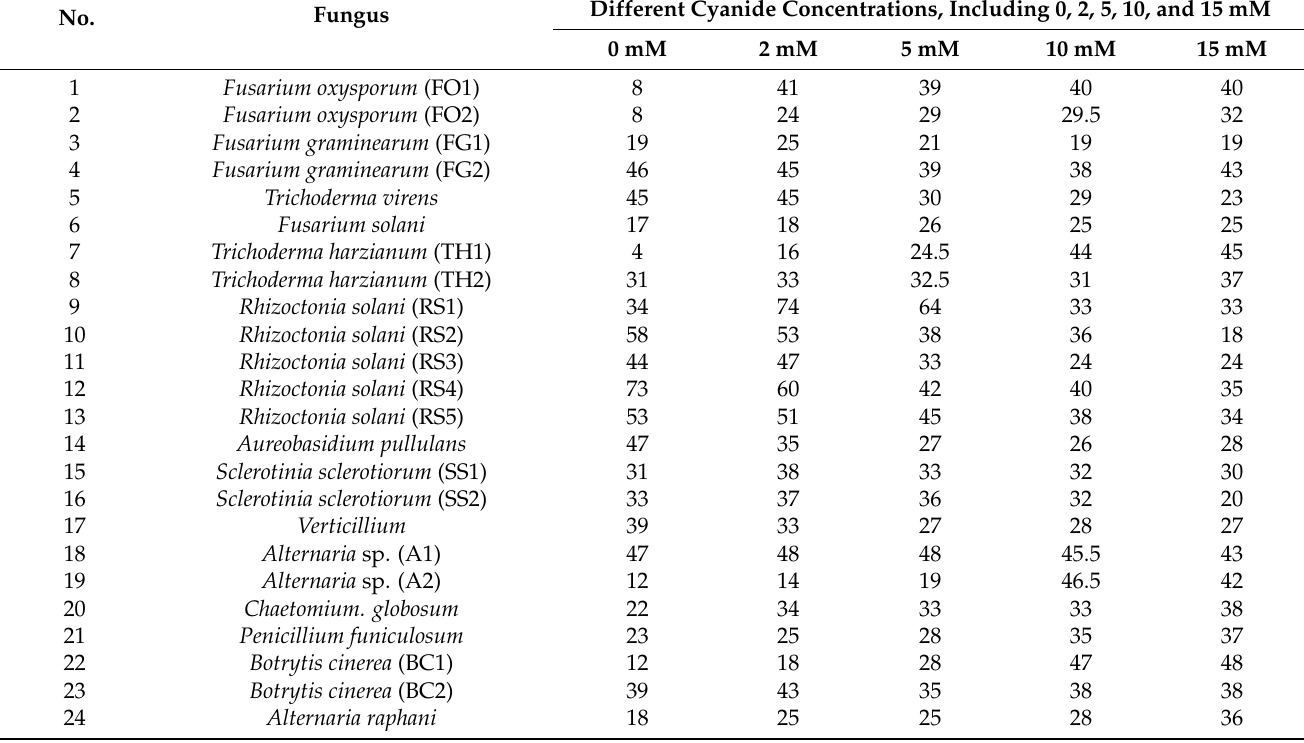
Table 1. Biomass of 24 fungal isolates cultured in four different cyanide-containing media (2, 5, 10, and 15 mM cyanide), achieved on day 7 of